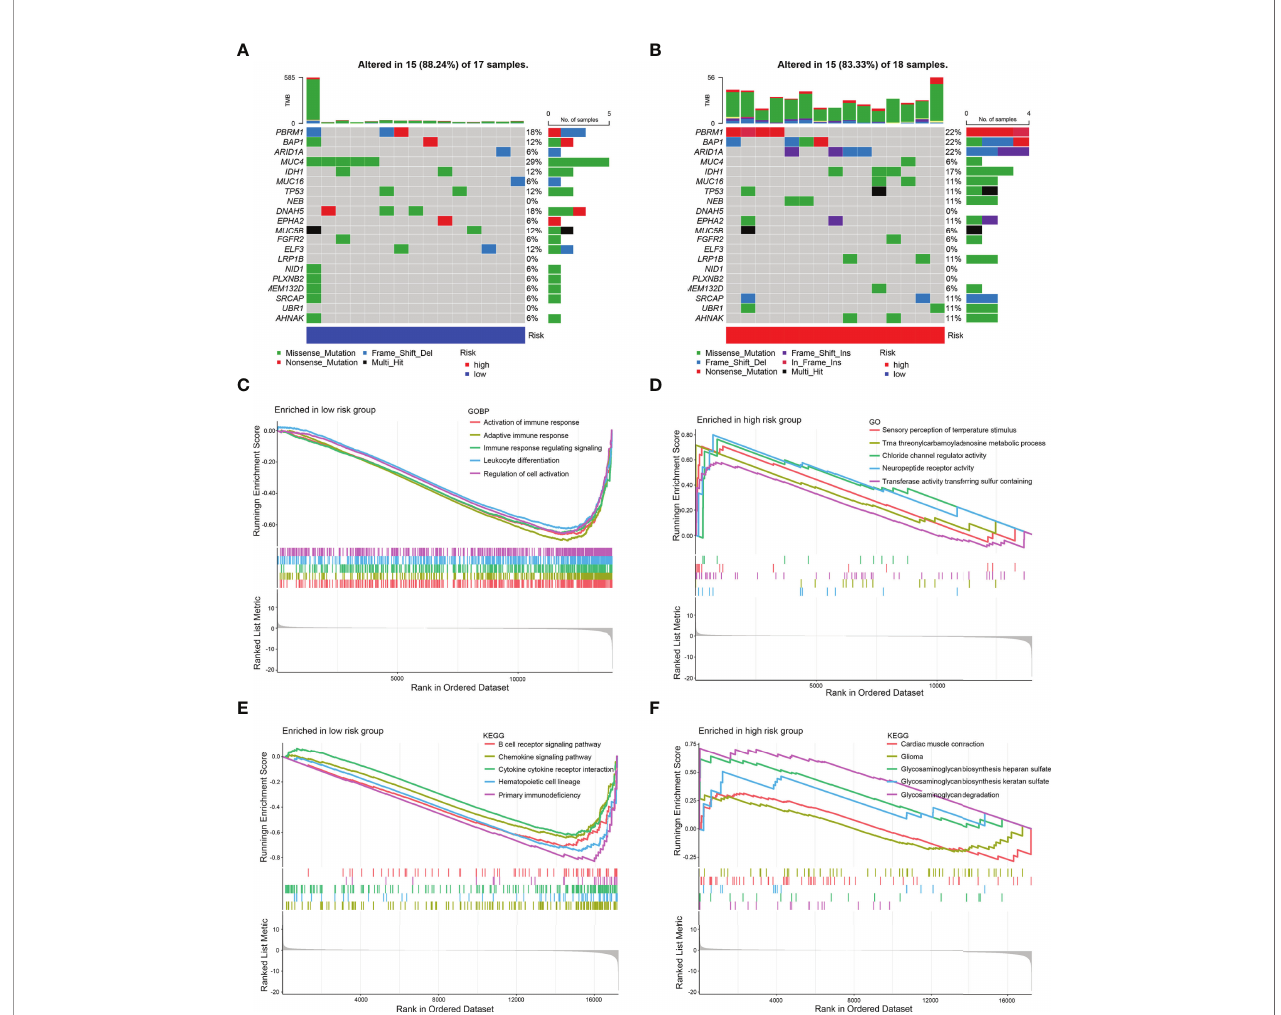
FIGURE 5 | Mutation analysis and GSEA. (A) Signi fi cantly mutated genes in the mutated CCA samples of the low-risk subgroup. (B) Signi fi cantly mutated genes in the mutated CCA samples of the high-risk subgroup. [Samples (columns) are arranged to emphasize mutual exclusivity among mutations. The right panel shows the mutation percentage, and the top panel shows the overall number of mutations. The color coding indicates the mutation type.] (C) Gene sets enriched in the low-risk subgroup ( p < 0.05). (D) Gene sets enriched in the high-risk subgroup ( p < 0.05). (E) KEGG pathway in the low-risk subgroup ( p < 0.05). (F) KEGG pathway in the high-risk subgroup ( p <